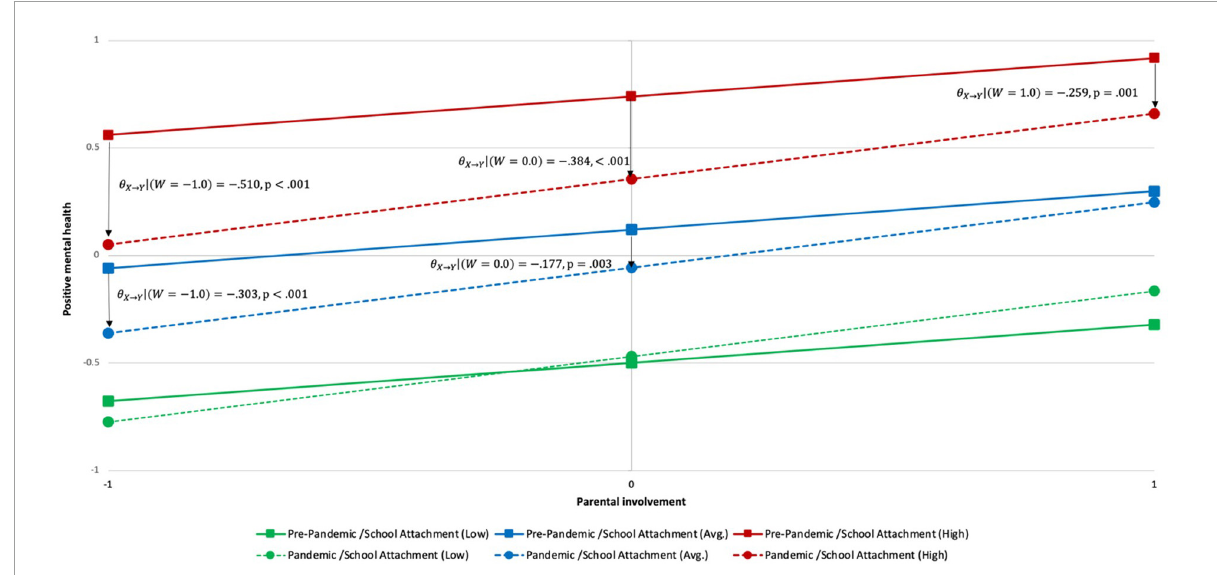
FIGURE1 Pre-Pandemic and pandemic slopes between parental involvement and positive mental health by level of school attachment among 2SLGBTQ +